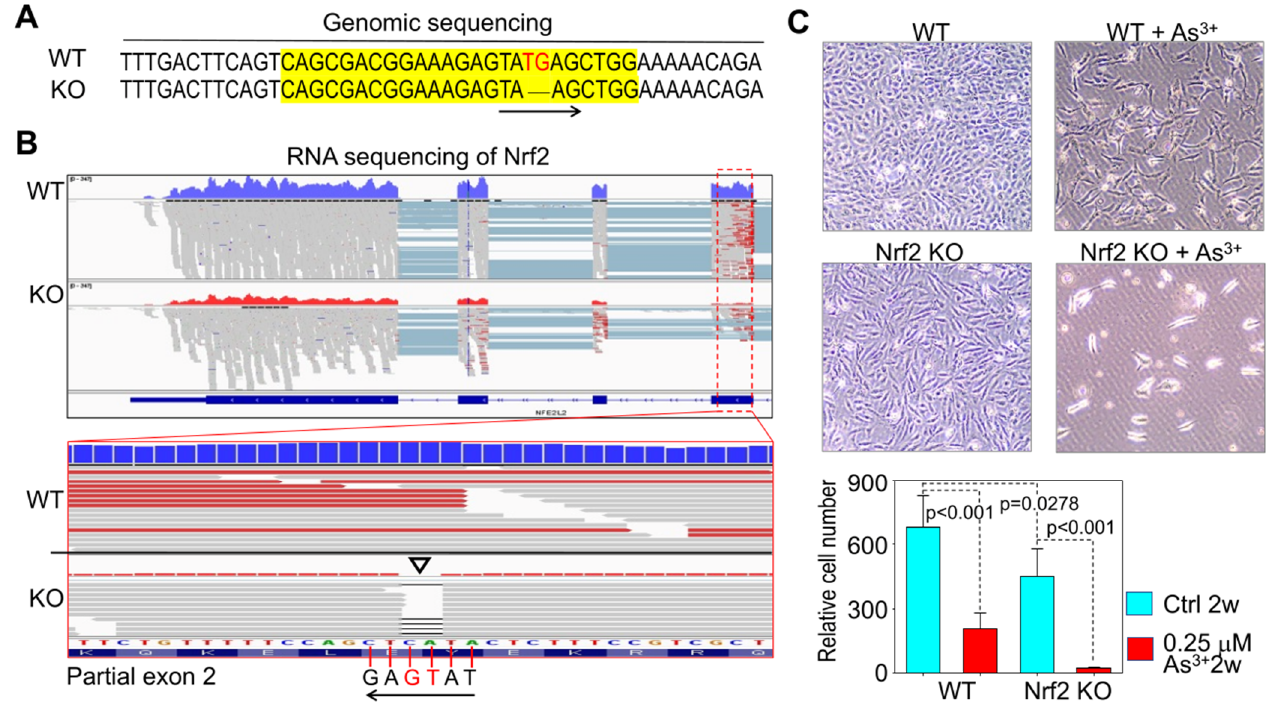
Figure 3. Gene knockout of Nrf2 prevents arsenic-induced malignant transformation. ( A ). BEAS-2B cells were subjected to CRISPR-Cas9 gene editing using sgRNA that targets the exon 2 region of the Nrf2 genes. Successful knockout of Nrf2 gene was confirmed by genomic sequencing. The sequences highlighted with yellow color are the sgRNA targeting region in CRISPR-Cas9 editing. The knockout (KO) cells showed “thymine-guanine (TG)” deletion. ( B ). RNA-seq showed deletion of the TG complement nucleotides cytosine-adenine (CA) in the exon 2 transcripts in Nrf2 KO cells (pointed by an open triangle). ( C ). Cell viability analysis of the WT and Nrf2 KO cells in the absence or presence of 0.25 μM arsenic (As 3+ ) for 20 days. Cell numbers were averages of cell counting in four randomly selected microscopic fields. Sigma plot t test was used to determine the statistical significance. p < 0.05 was considered statistically significant.